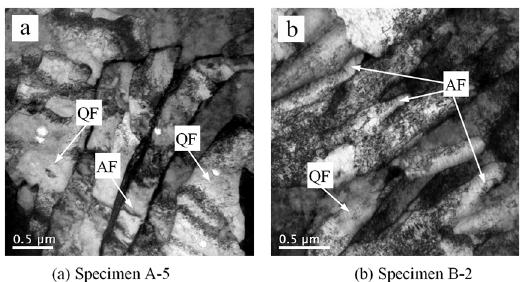
Figure 7. TEM micrographs of specimens showing the formation of quasi polygonal ferrite (QF) and acicular ferrite (AF).